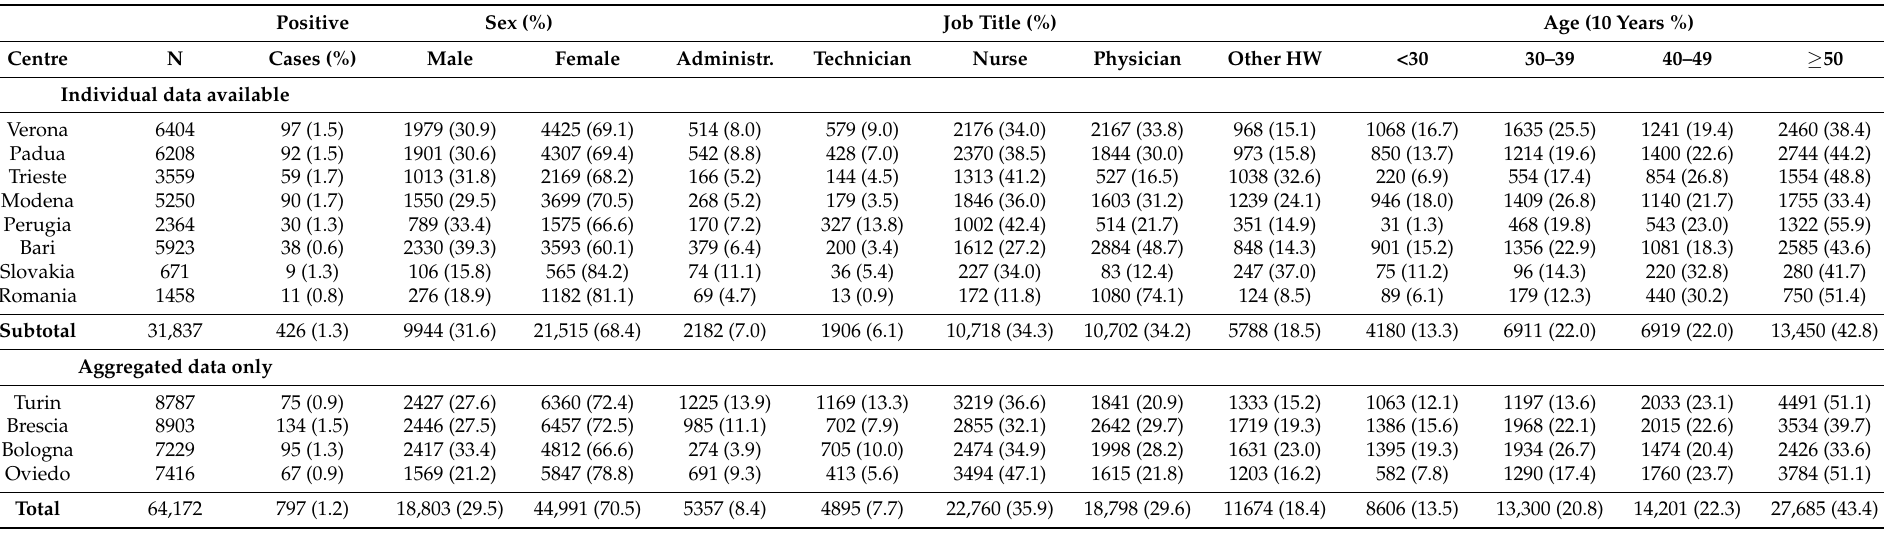
Table 1. Breakthrough infections, demographic, and occupational characteristics of 64,172 Health Workers from 12 European